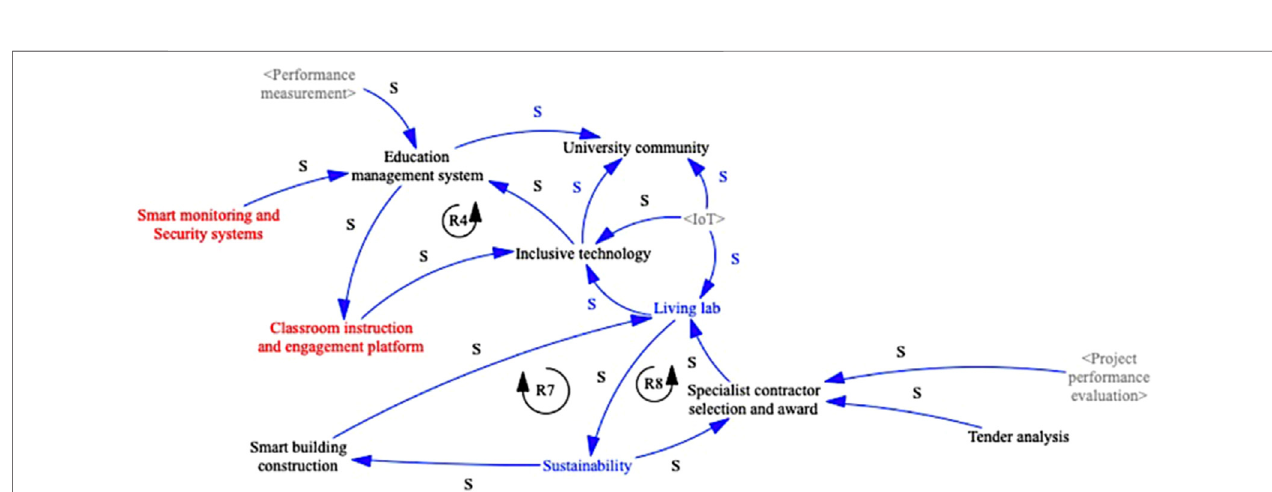
FIGURE 8 | System archetype 3- Smart campus construction. Source: Authors.